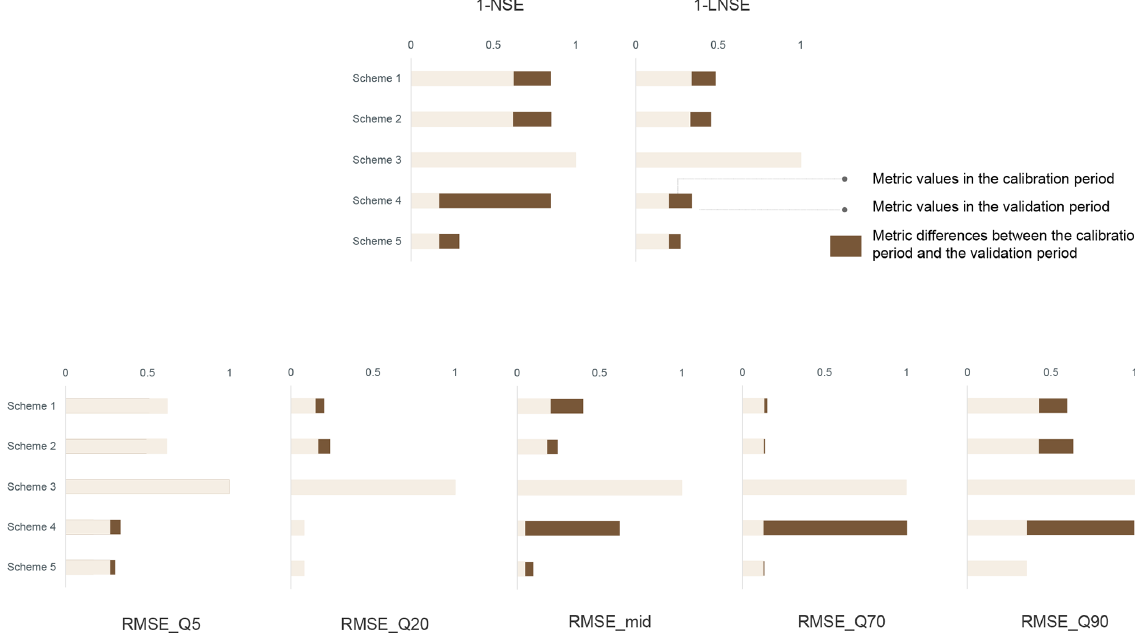
Figure 3. Model performance. Model performance of the five schemes in the Hanzhong basin; (1) the performance in different phases of the streamflow and (2) the transferability of dynamic parameters to different time